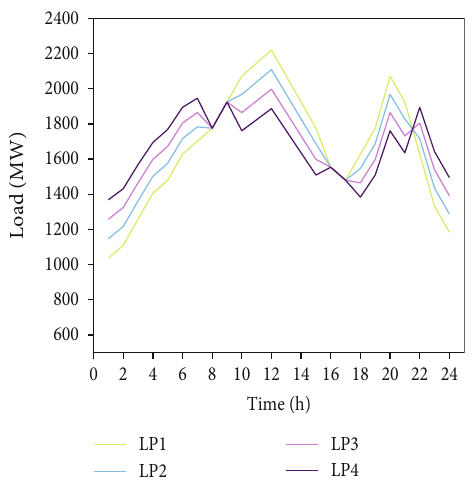
Figure 1: Twenty-four-hour load pro fi les